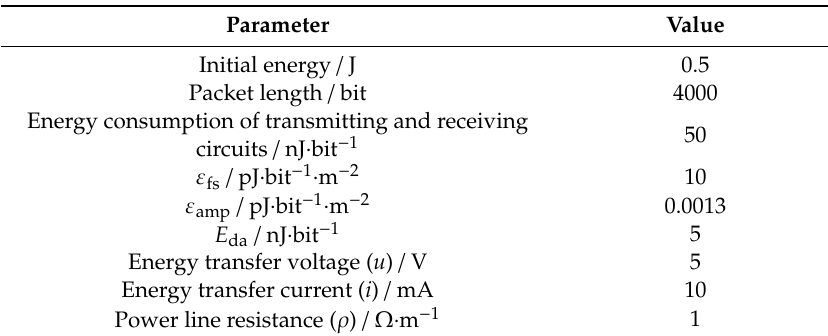
Table 1. Simulation parameters.